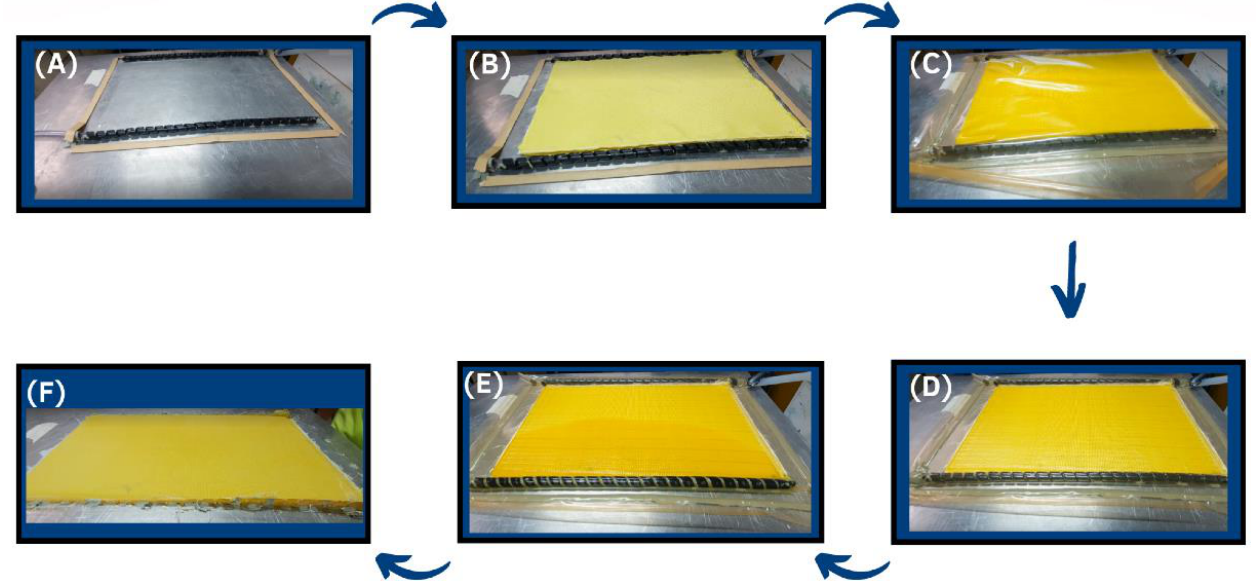
Figure 2. Manufacturing steps for VI processing: ( A ) surface preparation, ( B ) fabric stacking, ( C ) vacuum bag closing, ( D ) closed system, ( E ) resin permeation, and ( F ) final laminate.